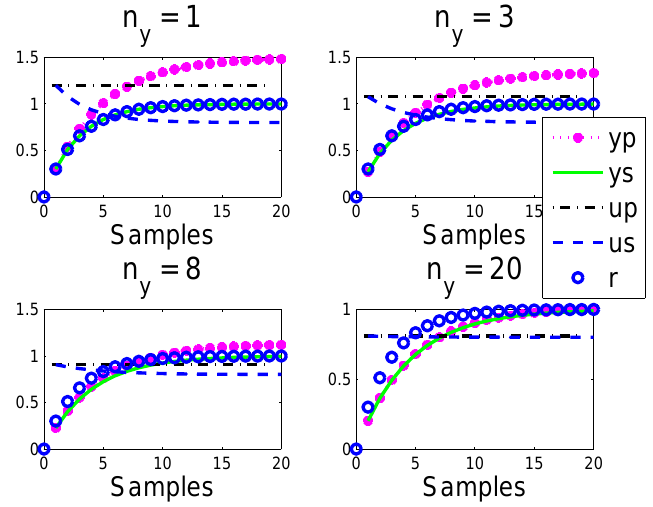
Figure 6. Closed-loop PFC input and output us; ys responses overlaid with predictions up; yp made at the first sample for a > (cid:26) .